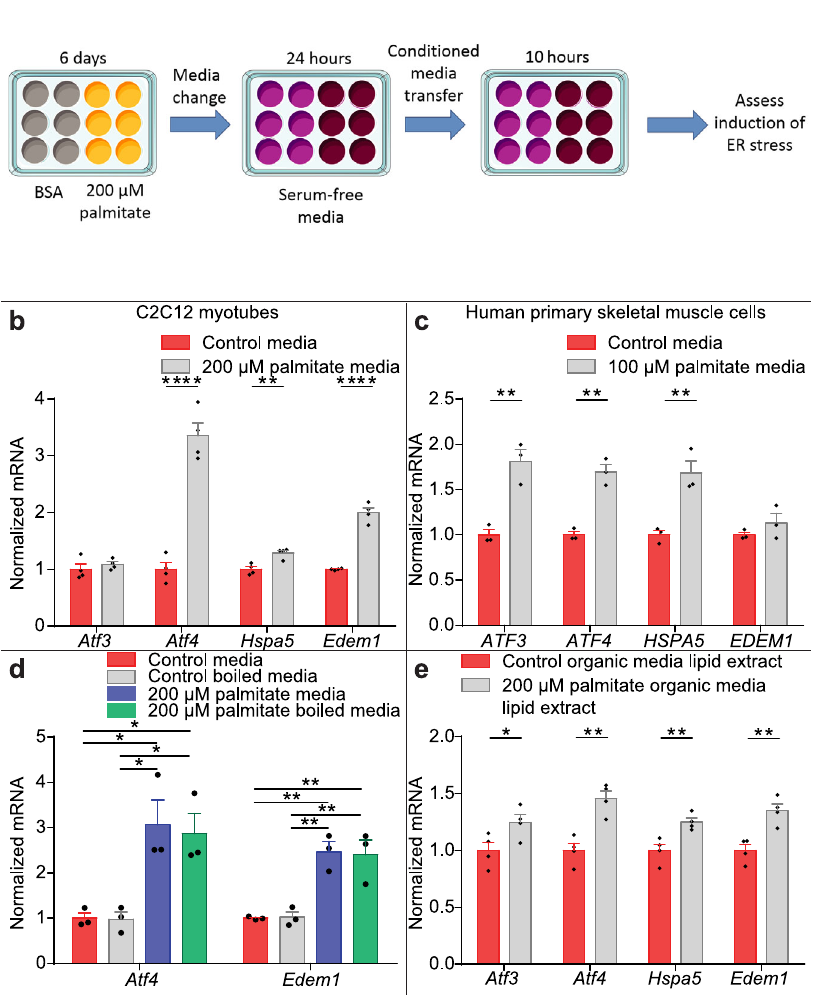
Fig. 1 Myotubes secrete a cell non-autonomous unfolded protein response (UPR) -inducing lipid signal in response to lipotoxicity. a C2C12 myotubes were treated with 200 µ M palmitate or bovine serum albumin (BSA) vehicle, serum-free media was conditioned on these cells (24 h) and transferred to naïve myocytes. b Activating transcription factor 3 ( Atf3 ), activating transcription factor 4 ( Atf4 ), Heat Shock Protein Family A (Hsp70) Member 5 ( Hspa5 ) and ER Degradation Enhancing Alpha-Mannosidase Like Protein 1 ( Edem1 ) UPR gene expression in C2C12 myotubes receiving conditioned media from myotubes treated with 200 μ M palmitate (grey) or BSA (red) ( n = 4; two-tailed Student ’ s t test; Atf4 P = 0.00009, Hspa5 P = 0.005, Edem1 P = 0.000024). c UPR gene expression in human skeletal muscle cells (HSkMCs) receiving conditioned media from HSkMCs treated with 100 μ M palmitate (grey) or BSA (red) ( n = 3, two-tailed Student ’ s t test; ATF3 P = 0.005, ATF4 P = 0.0017, Hspa5 P = 0.0088). d UPR gene expression in myotubes receiving boiled media conditioned on C2C12 myotubes treated with 200 μ M palmitate or BSA (control = red; control boiled = grey; 200 µ M palmitate = blue; 200 µ M palmitate boiled = green; n = 3; one-way ANOVA; control media vs 200 µ M palmitate media, Atf3 P = 0.017, Atf4 P = 0.005; control vs 200 µ M palmitate boiled, Atf3 P = 0.03, Atf4 P = 0.0065; control boiled vs 200 µ M palmitate, Atf3 P = 0.016, Atf4 P = 0.005; control boiled vs 200 µ M palmitate boiled, Atf3 P = 0.027, Atf4 P = 0.007). e UPR gene expression in myotubes receiving reconstituted lipid extract isolated from media conditioned on C2C12 myotubes treated with 200 μ M palmitate (grey) or BSA (red) ( n = 4; two-tailed Student ’ s t test: Atf3 P = 0.05, Atf4 P = 0.0026, Hspa5 P = 0.0097, Edem1 P = 0.0048). * P ≤ 0.05, ** P < 0.01, *** P < 0.001, **** P < 0.0001. Data are expressed as mean ± SEM with individual data points. Source data are provided as a Source Data fi